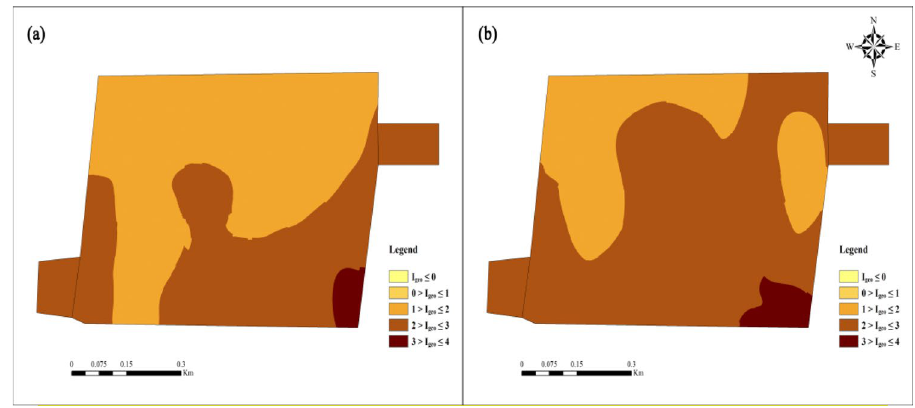
Figure 13. Evaluation results of geoaccumulation index method ( a ) Pb ( b ) Cd.